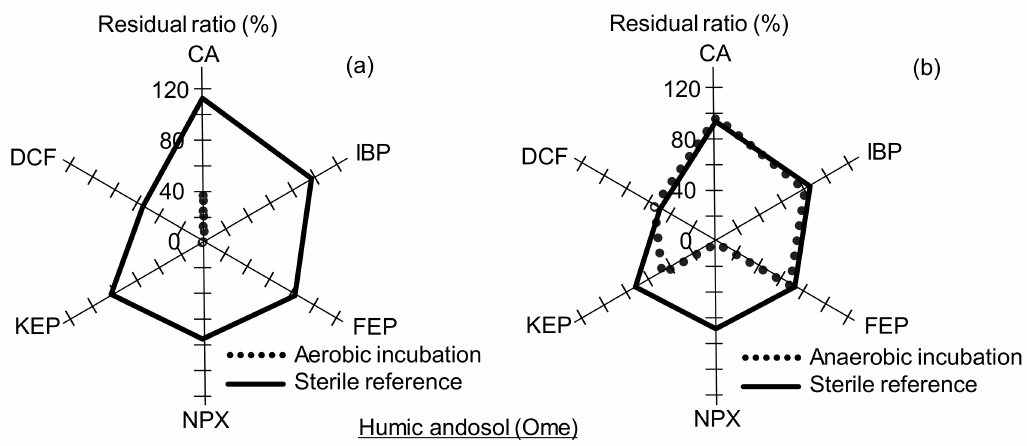
Figure 2. Residual ratios of the pharmaceuticals in humic andosol (Ome) slurry after 14 days of incubation under aerobic ( a ) and anaerobic ( b )